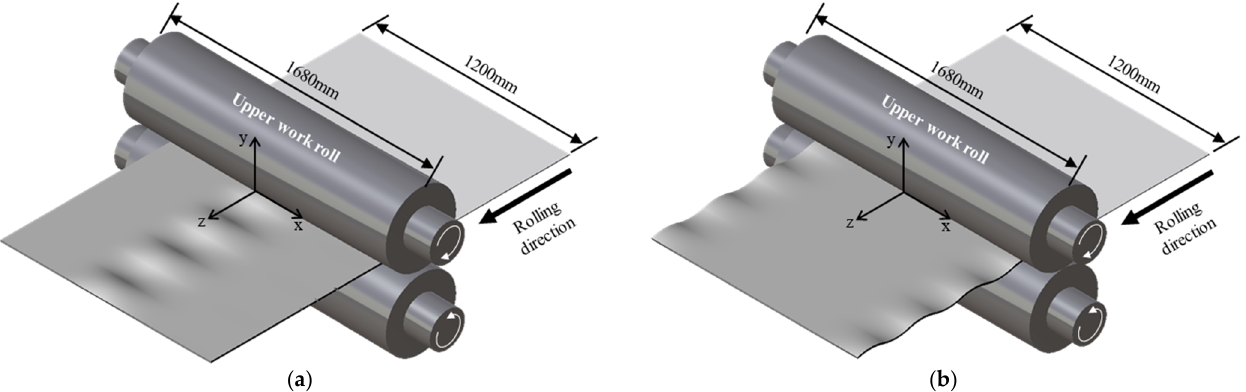
Figure 1. Scheme of change in the cross section of the strip due to roll bending. ( a ) Central wrinkle (center buckle) by positive roll bending; ( b ) Edge waviness by negative roll bending.